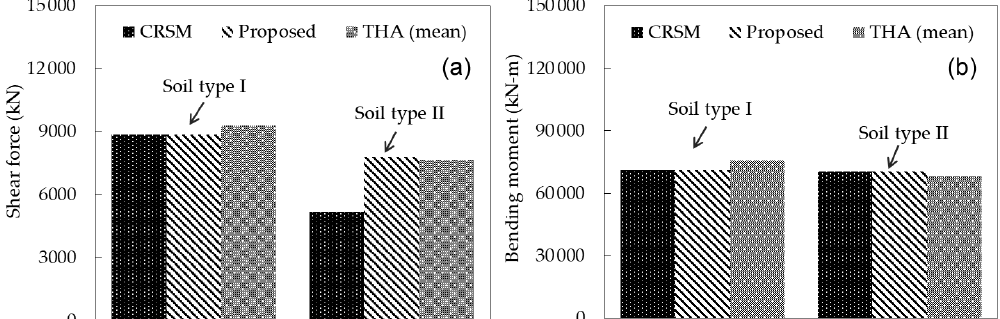
Figure 6. Seismic loadings on the footing: (a) shear forces and (b) bending